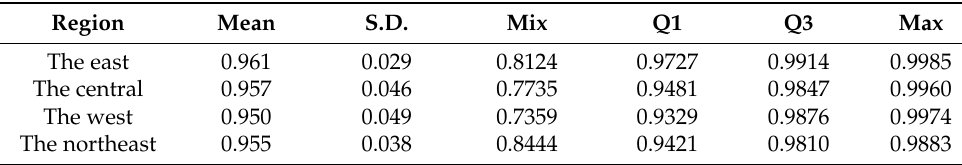
Table 4. Statistical description of regional energy technical